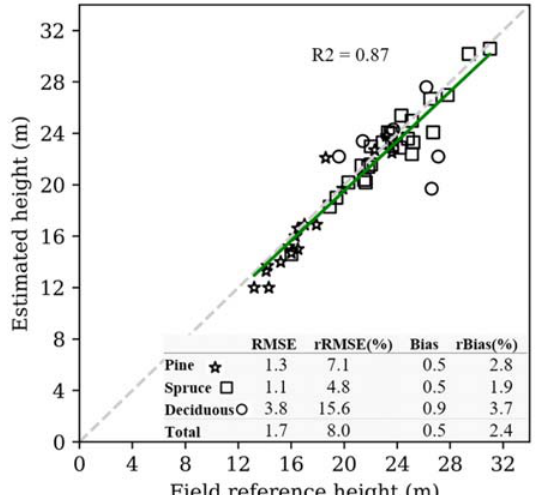
Figure 10. Mean tree height estimation (meter) using watershed segmentation method with LML data per each and all species